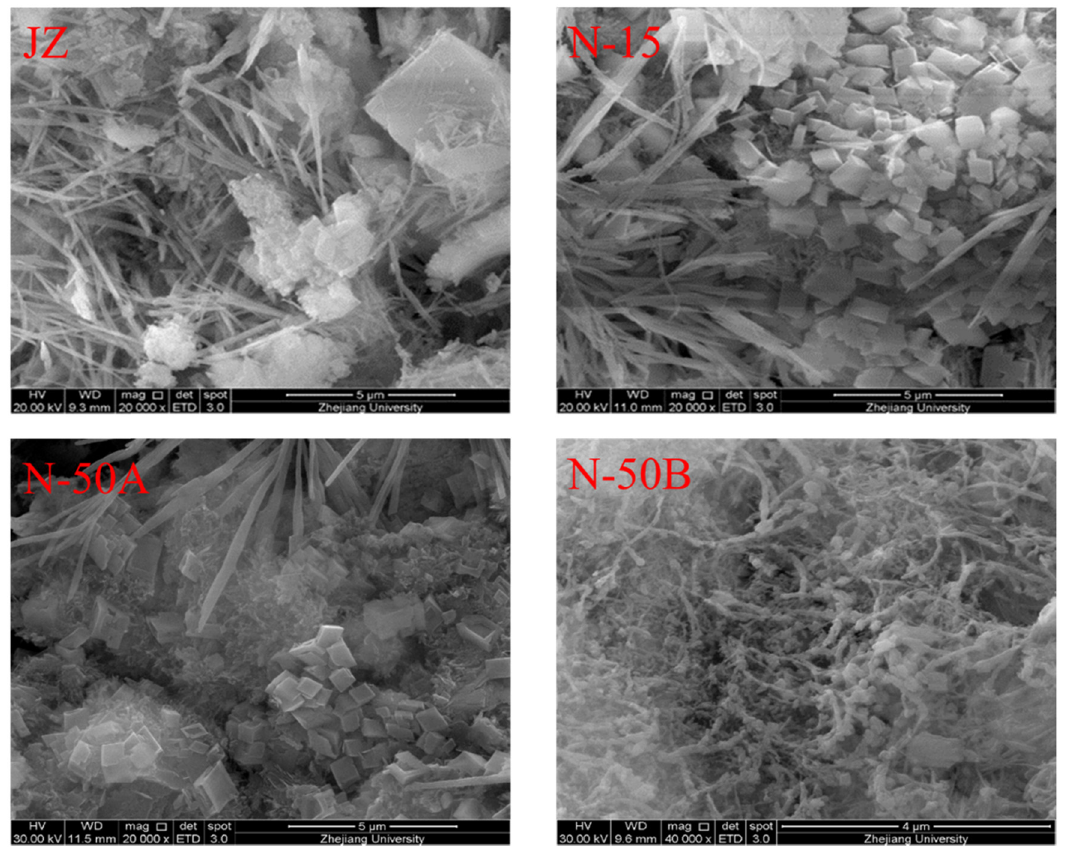
Figure 8: Main hydration products of specimens.